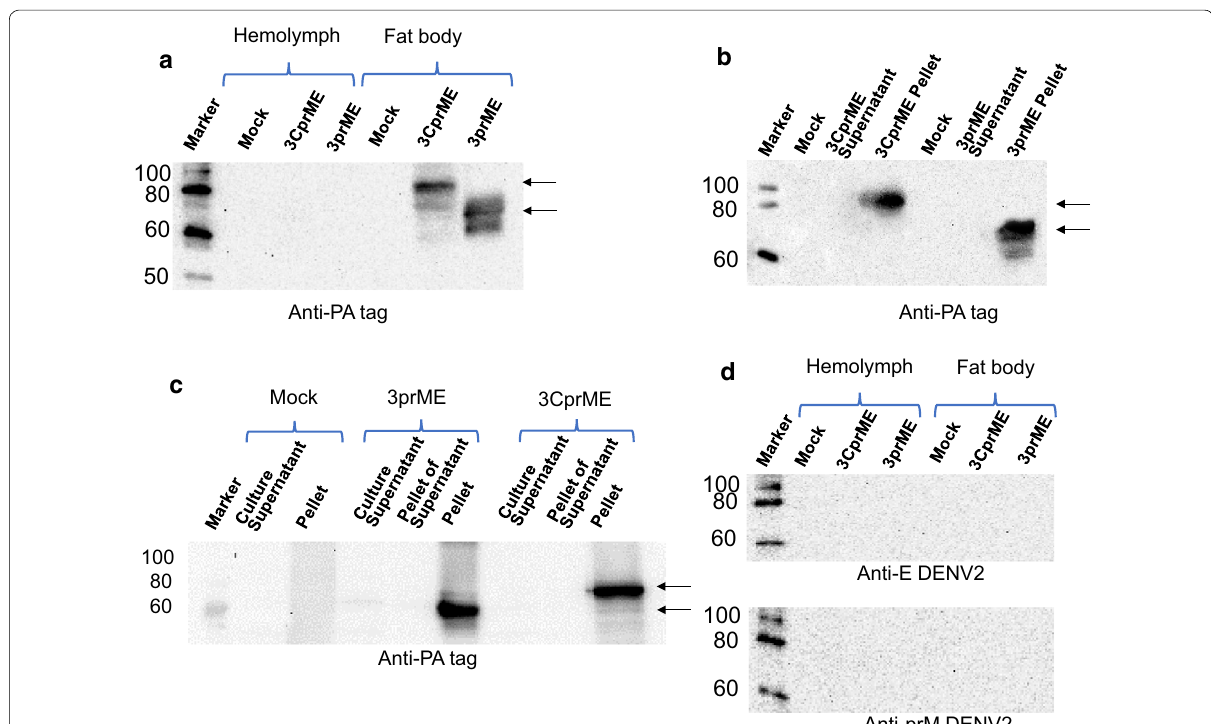
Fig. 2 Expression of 3CprME and 3prME polypeptides in silkworm larvae ( a ), pupae ( b ), and Bm5 cells ( c ). In the case of silkworm larvae, hemolymph, and fat body were collected after infection with recombinant BmNPV. Homogenates of each sample were prepared according to the protocol described in “Materials and methods”. The 3CprME and 3prME polypeptides were detected by western blot using rat anti-PA tag as a primary antibody. d Hemolymph and fat body from silkworm larvae were verified for cross-reaction using mouse anti-E antibody (anti-E DENV-2) and mouse anti-prM antibody (anti-prM DENV-2) of DENV serotype